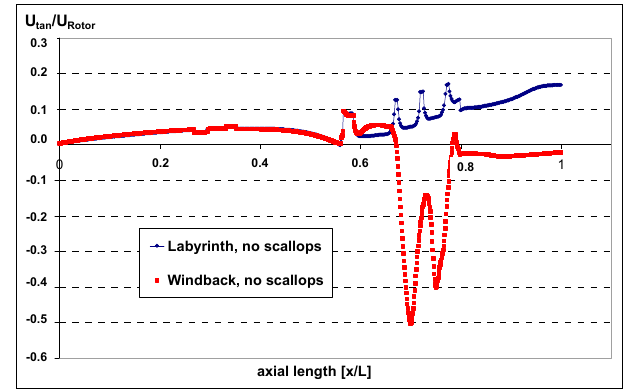
Figure 10. Tangential velocity components as a function of the axial length for labyrinth and windback (smooth rotor) at 12 g/s.